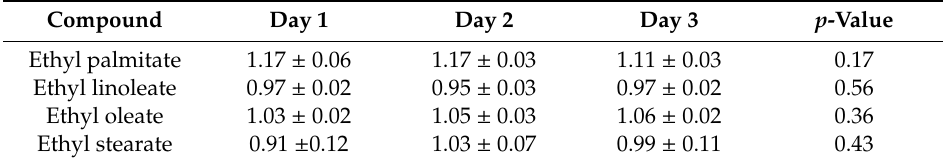
Table 4. Inter-day precision, obtained by adding a mix with the FAEE standards and the internal standard at 0.025 mg / mL (C4) to a refined olive oil, and expressed as the ratio between the area of each compound and the area of the internal standard; analyses were carried out in triplicate on three di ff erent days; p-values are calculated according to one-way ANOVA ( p ≤ 0.05).